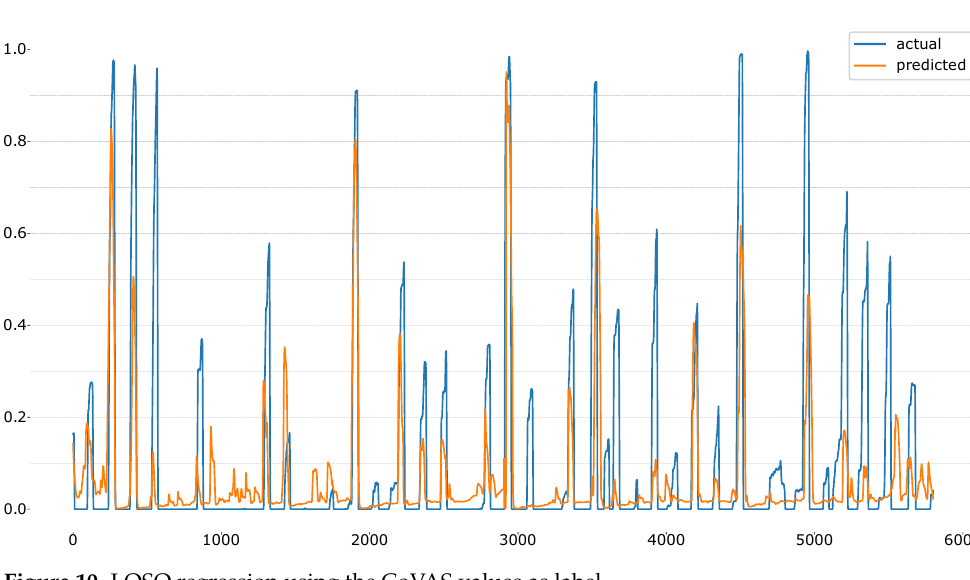
Figure 10. LOSO regression using the CoVAS values as label.